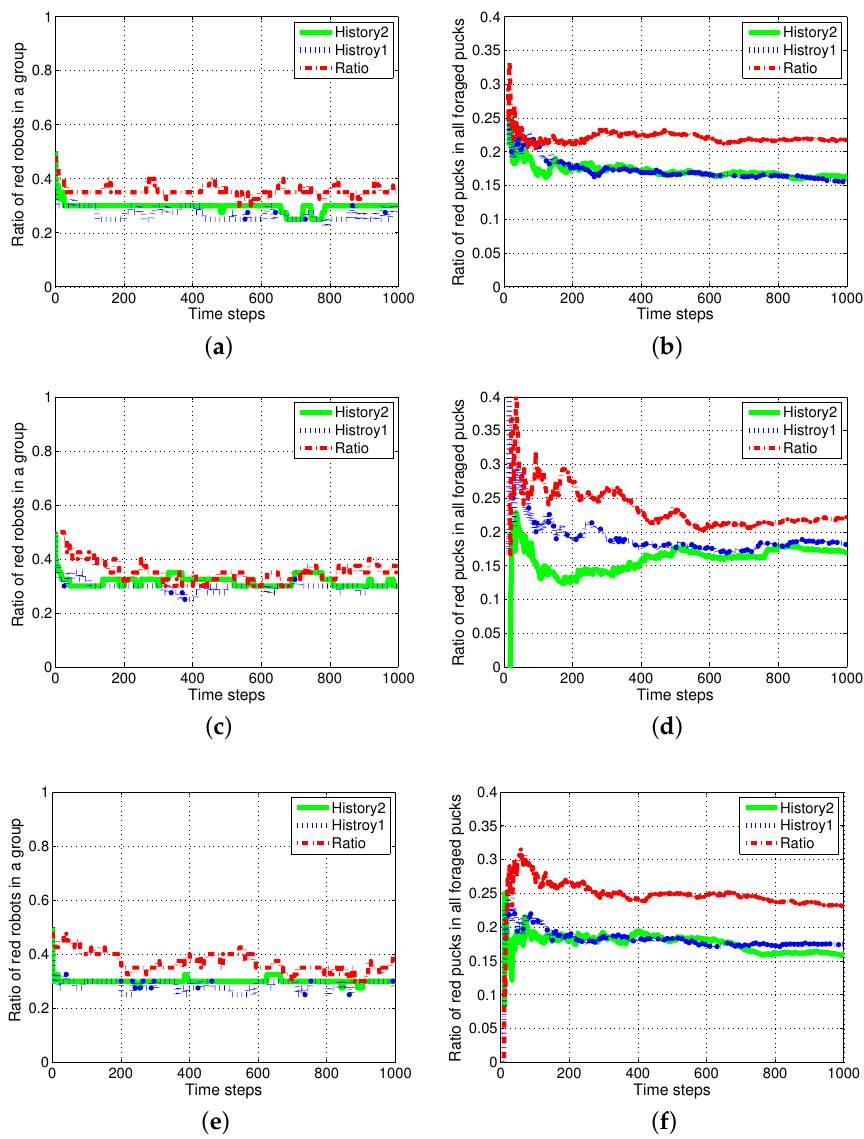
Figure 14. Ratio of robots foraging for red pucks in a group and the ratio of red pucks to all foraged pucks. ( a ) Robots foraging for red pucks (front 60 ◦ ); ( b ) ratio of red pucks (front 60 ◦ ); ( c ) robots foraging for red pucks (front 20 ◦ ); ( d ) ratio of red pucks (front 20 ◦ ); ( e ) robots for red pucks (front 20 ◦ , triple pucks); ( f ) ratio of red pucks (front 20 ◦ , triple